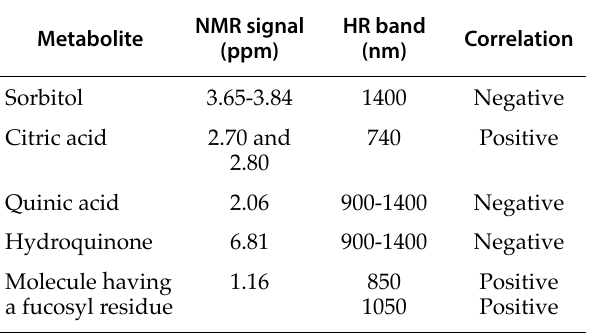
Table 1. NMR-HR covariance correlations for pear leaves sampled at 50